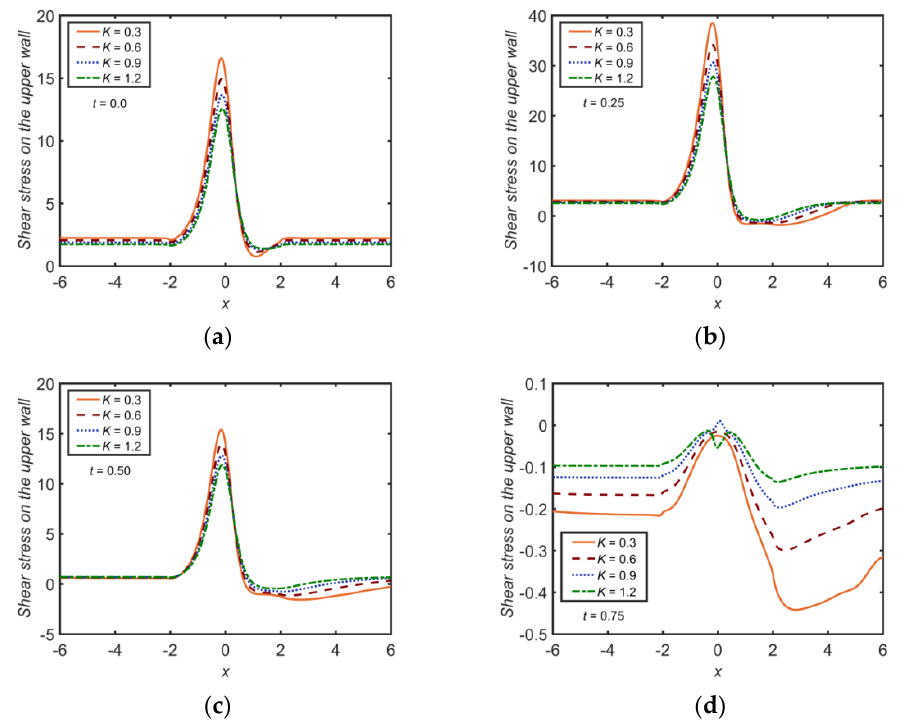
( d ) Figure 5. The WSS distribution on varying the values of (cid:1845)(cid:1872) with (cid:1839) = 5 , (cid:1837) = 0.6 , and (cid:1844)(cid:1857) = 700 at ( a ) (cid:1872) = 0 , ( b ) (cid:1872) = 0.25 , ( c ) (cid:1872) = 0.50 , and ( d ) (cid:1872) = 0.75 . The WSS at the four time levels for (cid:1837) = 0.3 , 0.6 , 0.9 , and 1.2 with (cid:1845)(cid:1872) = 0.02 , (cid:1839) = 5 , and (cid:1844)(cid:1857) = 700 is shown in Figure 6. The WSS fell with the increasing values of (cid:1837) during a complete cycle. During 0 < (cid:1872) < 0.25, the flow separation region had an inverse